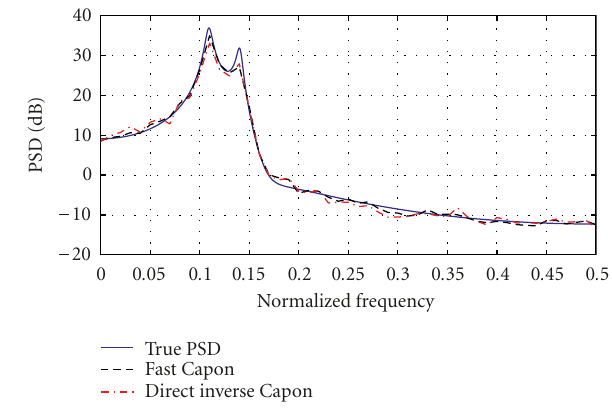
Figure 4: True and estimated power spectral densities for an ARMA process. Conditions of simulations: L = K = 100, λ = 1 − 1 / (5 L ), and N = 2000.